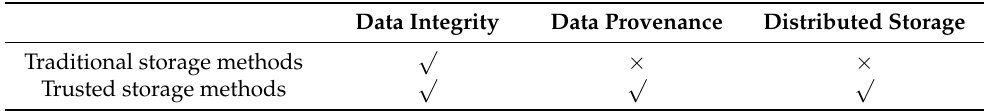
Table 3. A comparison between traditional and trusted storage